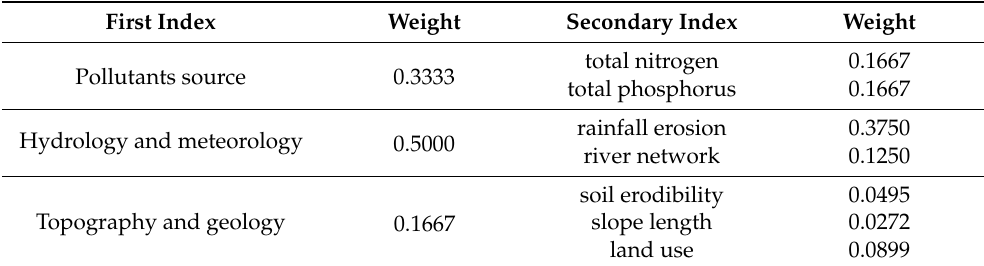
Figure 2. The AHP model structure of the risk assessment for nonpoint source pollution. Table 1. The weight results of indexes.